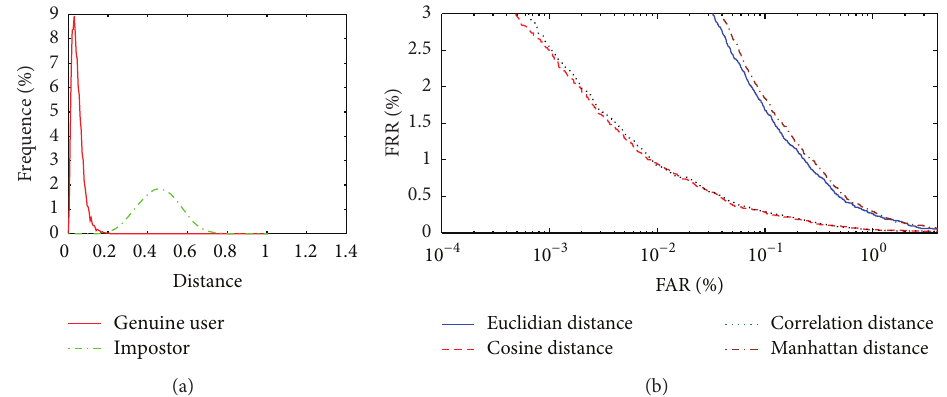
Figure8:(a)Distributionofthegenuineuserandimpostorwithoutenhancementusingcosineclassifier.(b)ROCcurvewithoutenhancement to different classifiers.